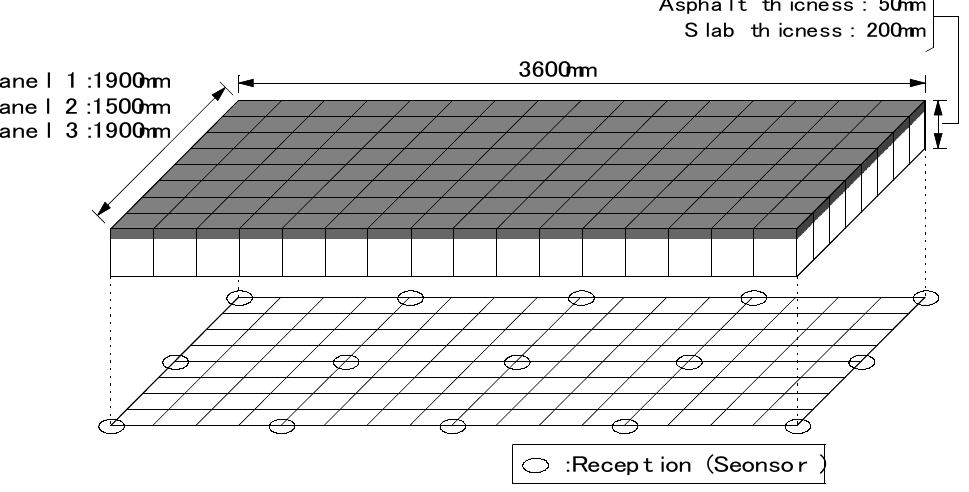
Figure 4. Analysis model for AE